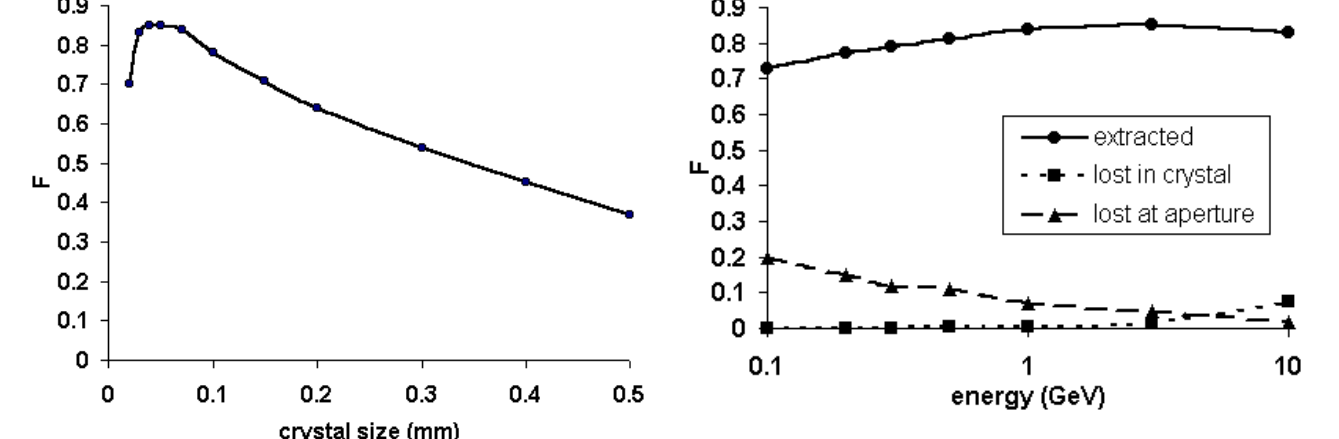
FIG. 3. Efficiency (dots) of crystal-assisted slow extraction, and beam lost in nuclear interactions in crystal (squares) and on the aperture (triangles), as functions of beam kinetic energy.